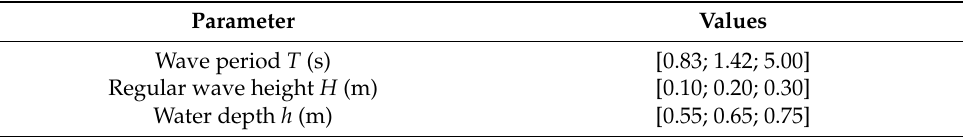
Table 3. Hydrodynamic characteristics for the SUSTAIN reef